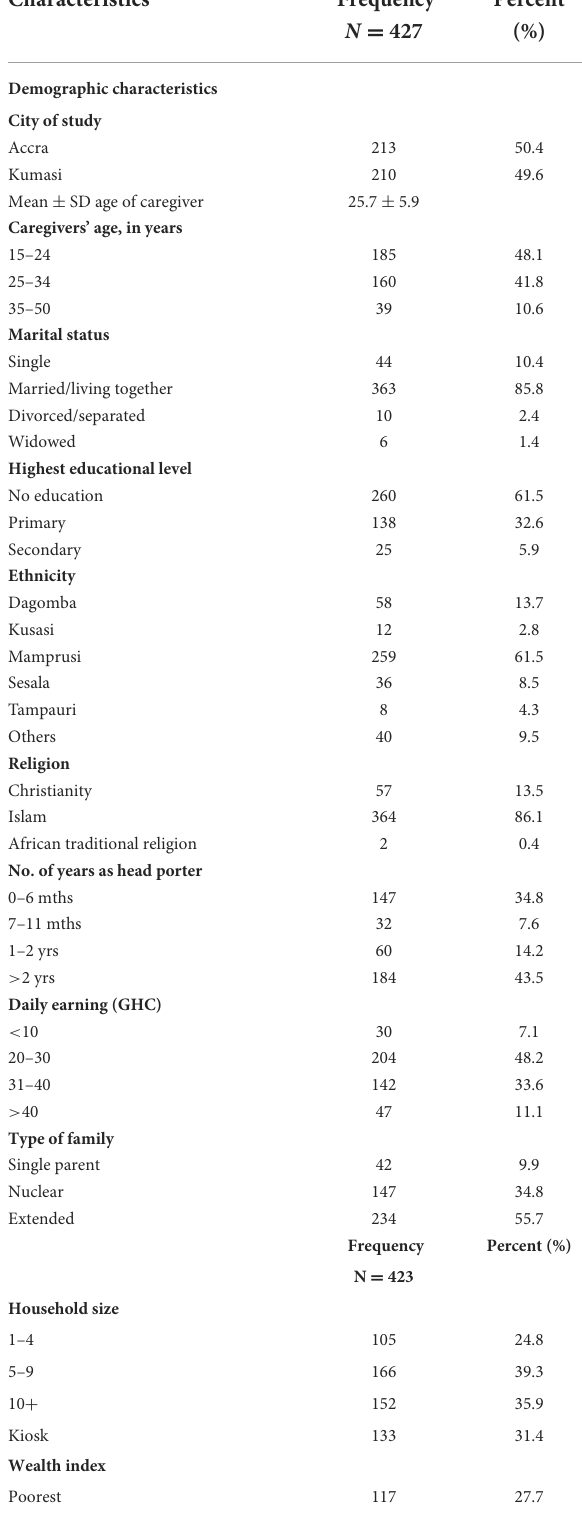
TABLE 1 Demographic and household characteristics of caregivers and children.